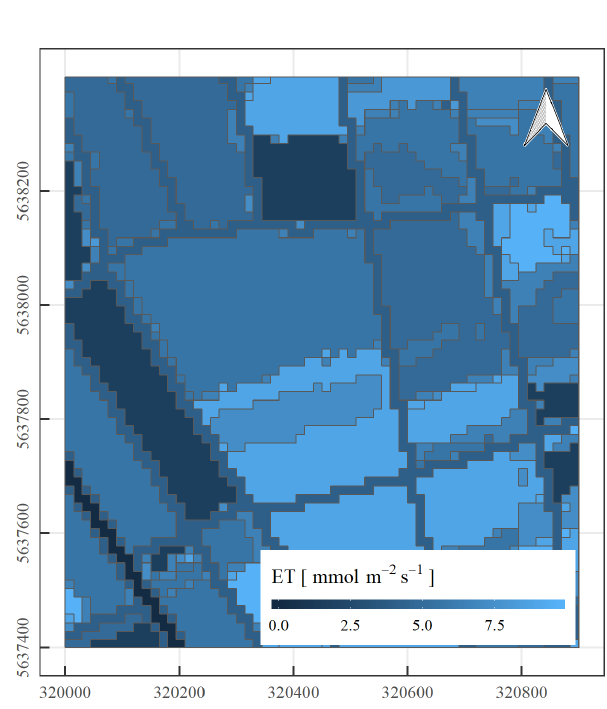
Figure 14. Spatial variability of evapotranspiration inferred from combining K c coefficients with the value of potential grass refer- ence ETgrass. The x and y axes represent the geographical coordi- nates of the CloudRoots site in metres (50 ◦ 52 (cid:48) 09 (cid:48)(cid:48) N, 6 ◦ 27 (cid:48) 01 (cid:48)(cid:48)